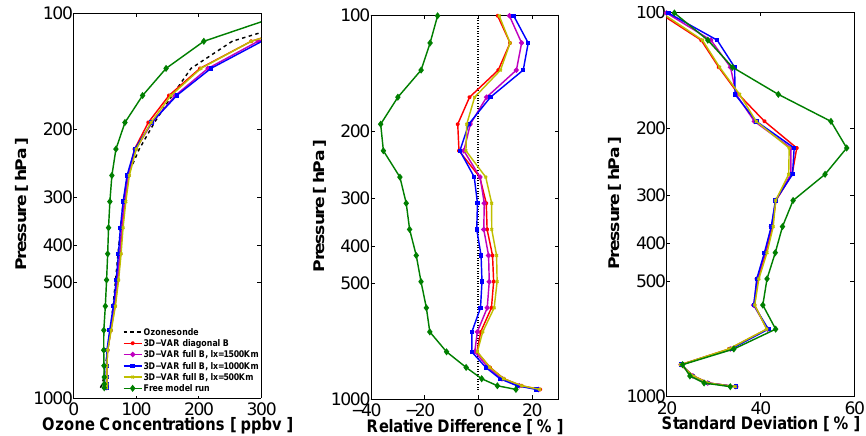
Fig. 4. The impact of non-diagonal background error covariances in 3D-Var data assimilation. Left panel: mean ozone concentrations at ozonesonde locations for 3D-Var analyses and free model trajectories. Center panel: relative mean errors of predicted ozone concentrations with respect to ozonesonde measurements. Right panel: standard deviation of absolute values of errors with respect to ozonesonde measure- ments. The data is averaged over all ozonesonde launches. These plots were generated from 2months simulation from 00:00GMT on 1 July to 23:00 GMT in August 2006 and compared against ozonesonde data available for the month of